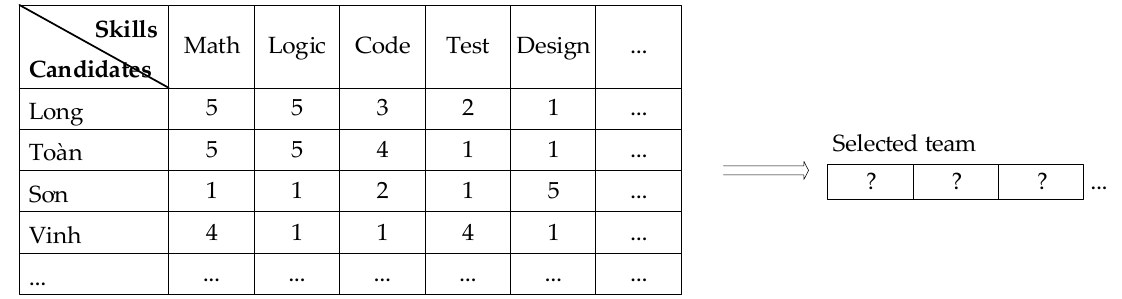
Figure 1. Illustration of the team selection problem. The table at the left of the figure describes the aggregated data through the competitions and training of the candidates. The goal is to select the team with the highest potential for achievement.